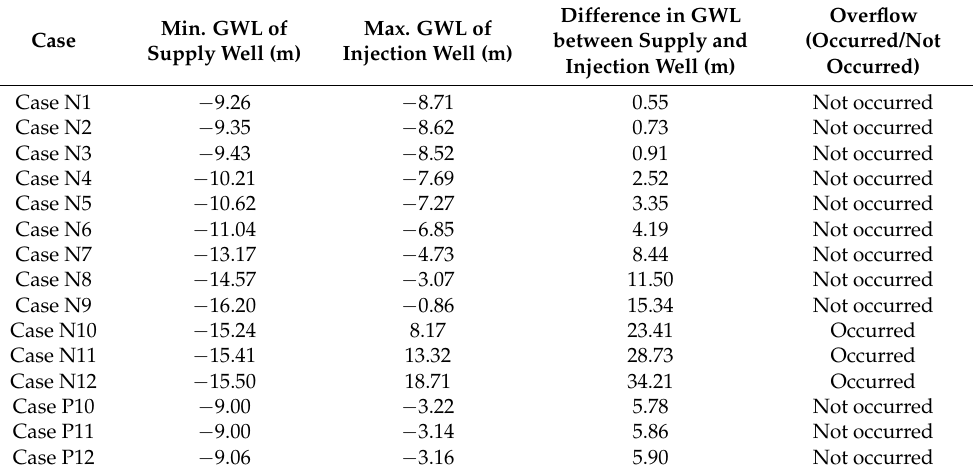
Table 8. Analysis results of all cases.